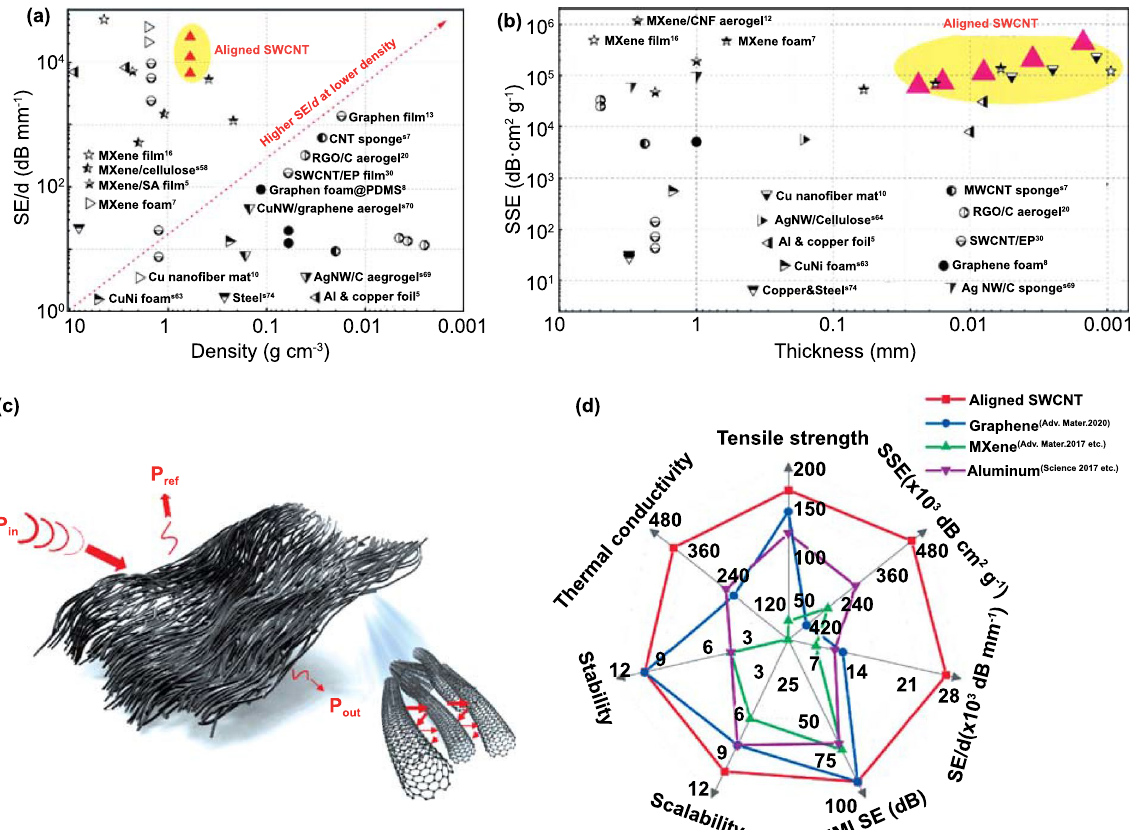
Fig. 4 a Shielding mechanism of the aligned SWCNT films. Comparison of the aligned SWCNT shielding performance with other shielding materials: b SE/ d values of the materials with various densities and c SSE values of the materials with various thicknesses. d Radar plots of the aligned SWCNT films with other shielding materials including some representative graphene [17], MXene [6, 8], and metal [6]-based